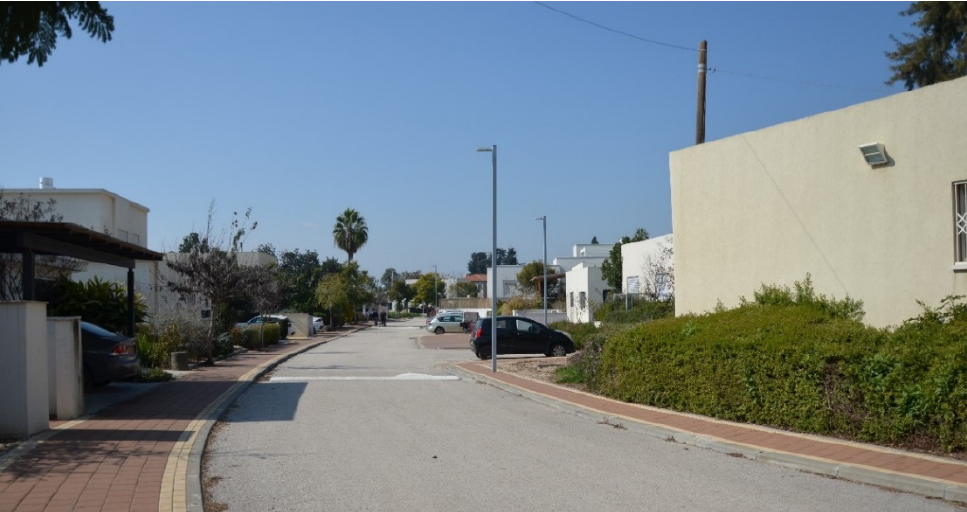
Figure 10. The houses of the internal extension at the center of Nahalal, designated for farmers’ inheritors who are not farmers, conveying a bourgeois lifestyle rather than the traditional values of equality, communalism, and agriculture. Photo by the authors.